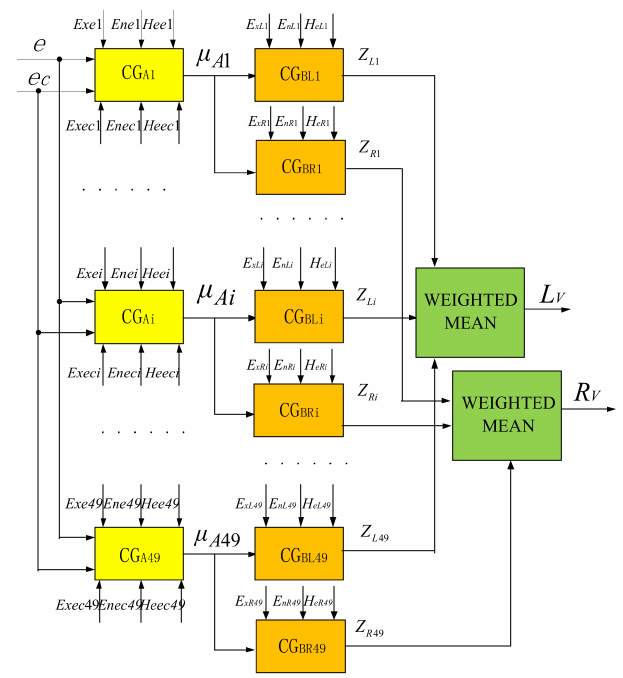
Figure 6. The diagram of rules reasoning for L v and R v with membership cloud model.